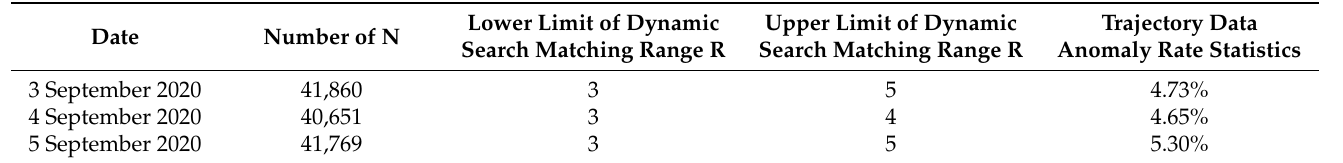
Table 1. The dynamic search matching range length and abnormal data rate of a three-day ETC transaction trajectory in Fujian